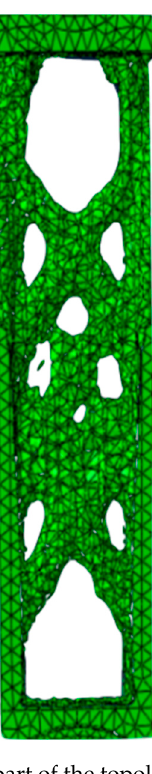
Figure 19. One part of the topological structure.